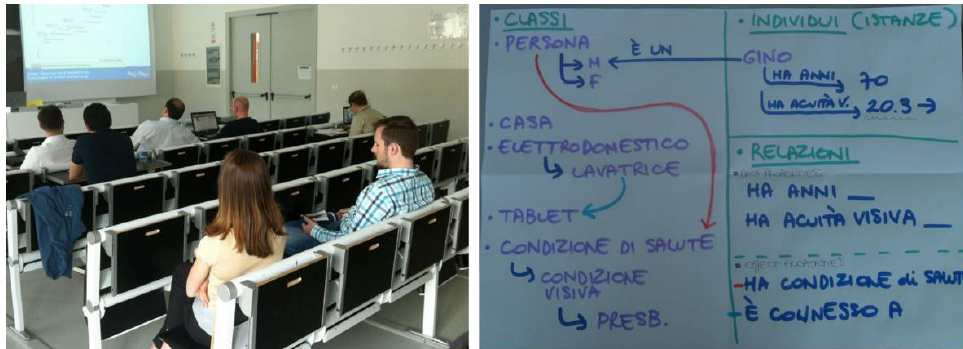
Figure 3. A picture from one of the workshops dedicated to the ontology for the project (on the left ) and a conceptual map of the same project (on the right ). The workshops were conducted in Italian considering the national scope of the project, while the ontology was developed in English to increase its reusability.